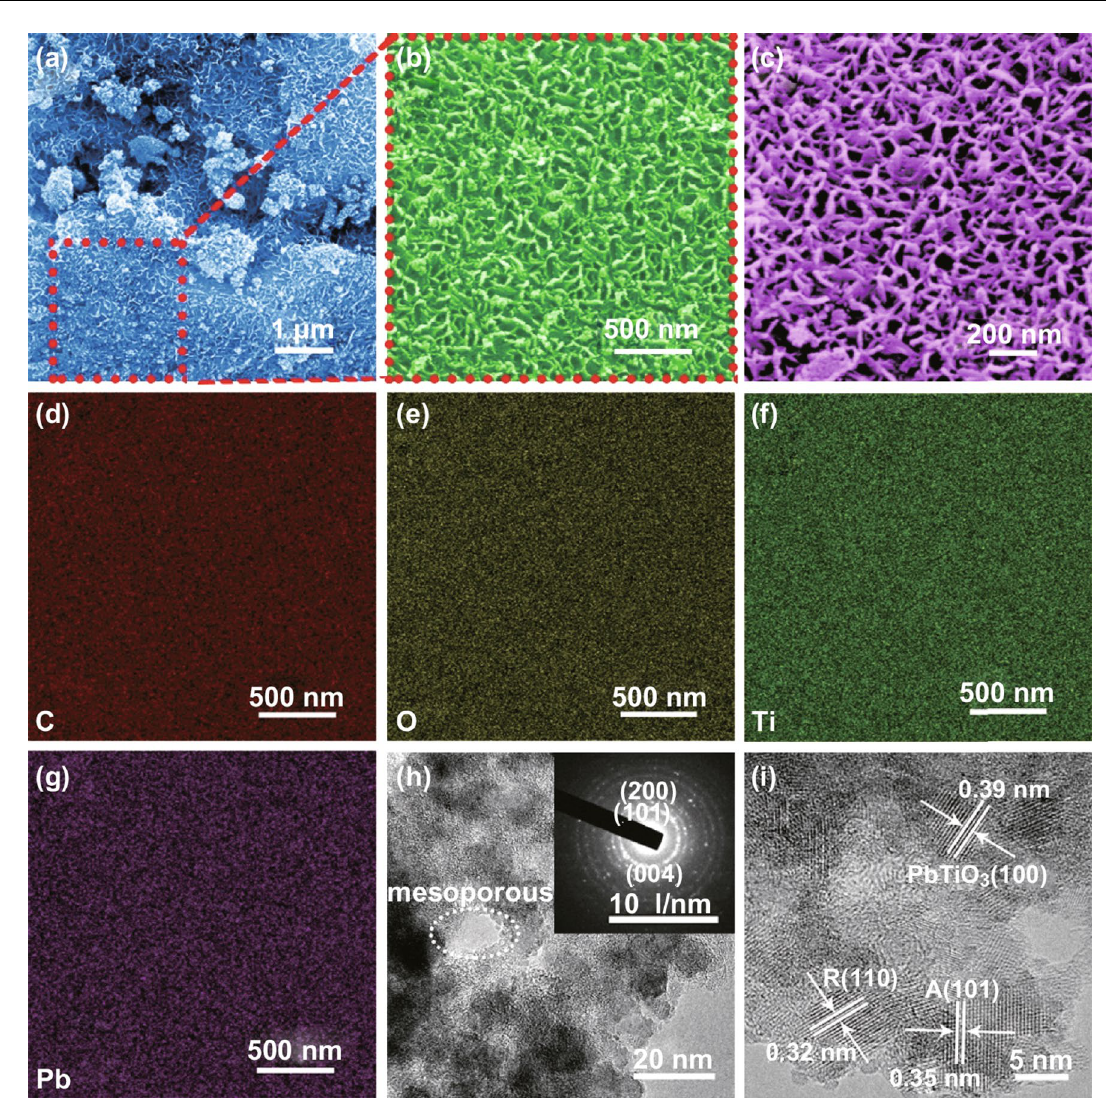
Fig. 3 Detailed microstructure analysis of PTC-900 composites: a–c SEM images with different magnification, d–g EDX elemental mapping, h bright field TEM image with selected area electron diffraction (SAED) pattern shown in the inset, and i high-resolution TEM image with lattice fringes of PbTiO 3 and TiO 2 highlighted in the